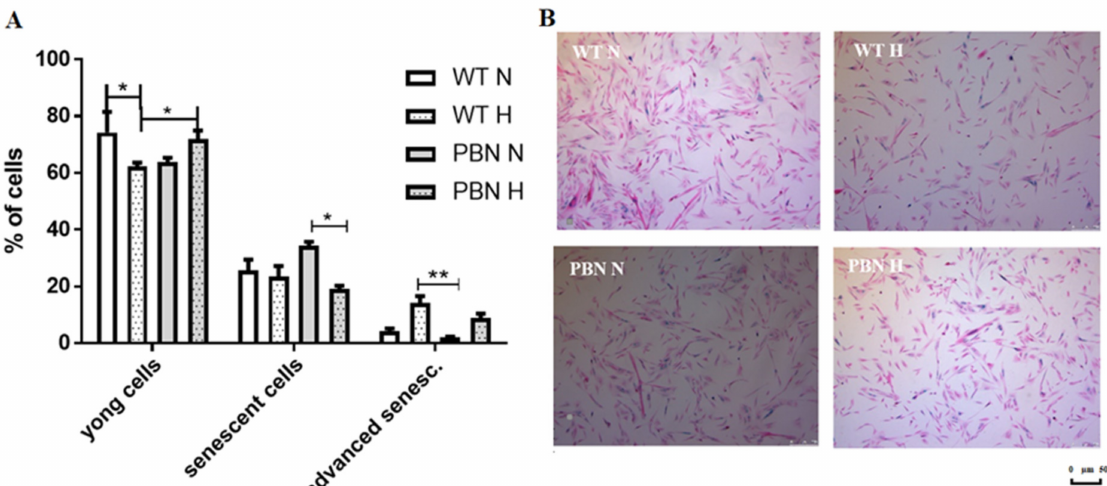
Figure 3. Percentages of young, senescent, and advanced senescent cells in the WT and PBN-treated SkMDS/PCs popu- lations ( A ). X-gal senescence assay, SkMDS/PCs observed under a light microscope ( B ). WT = non-treated SkMDS/PCs, PBN-SkMDS/PCs cultured with antioxidant in standard (N) and hypoxic (H) culture conditions. Abbreviations: SkMDS/PCs = skeletal muscle-derived stem/progenitor cells; WT = wild-type non-treated SkMDS/PCs; PBN = SkMDS/PCs cultured in medium conditioned with tert-butyl-alpha-phenyl nitrone. * significant at p value < 0.05, ** significant at p value < 0.01.